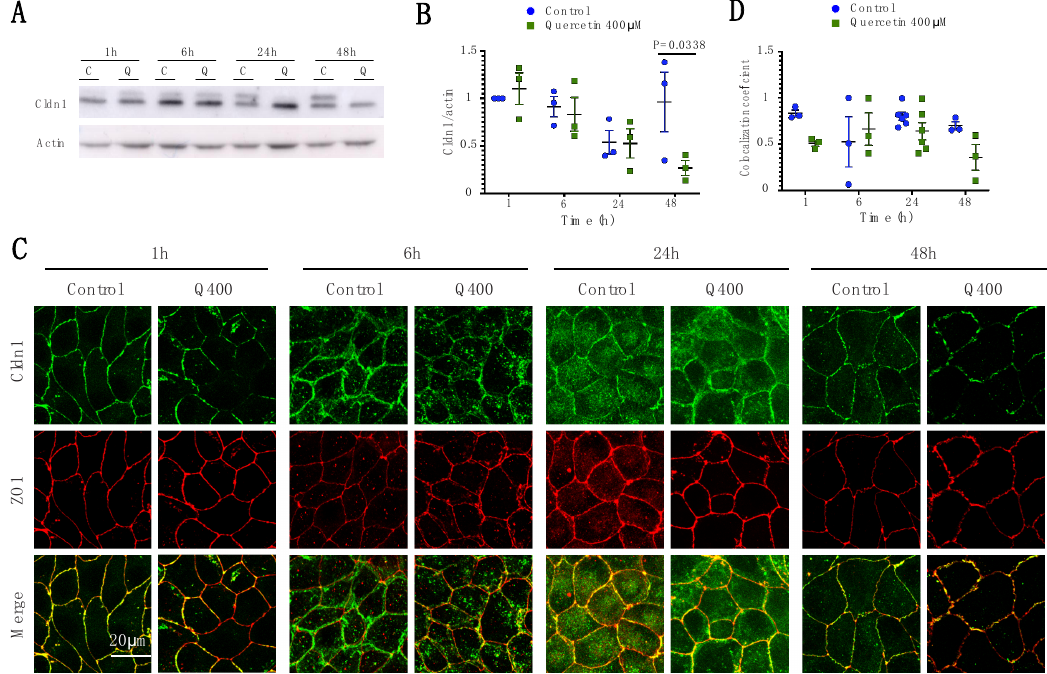
Figure 2. Analysis of Cldn1 expression and localization in MDCK II cells following quercetin treatment. ( A ) Western blot analysis of Cldn1 expression in cell lysates from control and 400 µ M quercetin-treated MDCK II cells. Actin was used as a loading control. ( B ) Densitometry measurements of Cldn1 and actin intensity on western blot were normalized to expression at 1h. Normalized Cldn1 expression relative to normalized actin expression is plotted (P int = 0.11; P time = 0.022; P treat = 0.16). ( C ) Immunofluorescence of control and 400 µ M of quercetin-treated MDCK II cells at 1, 6, 24, and 48 h. Cldn1 is shown in green and ZO1 is shown in red. ( D ) Localization of claudin at the tight junction was assessed by determining the amount of ZO1 that was co-localized with claudin expression (P int = 0.24; P time = 0.35; P treat = 0.055). For all graphs, each point corresponds to an independent experiment; mean and SEM are shown. C = Control and Q = Quercetin. Scale bar, 20 µ